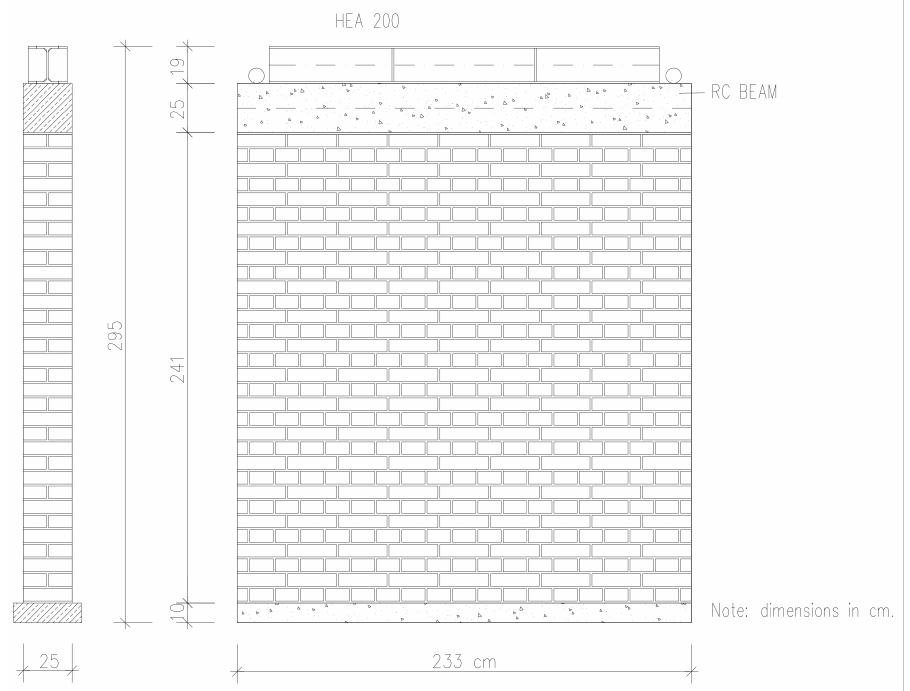
Figure 3. Geometry of the plain